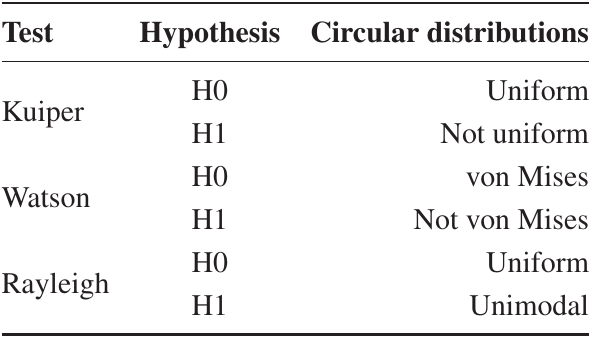
Table 1. Hypothesis for goodness of fit tests based on circular distributions. All tests were performed at the 5% significance